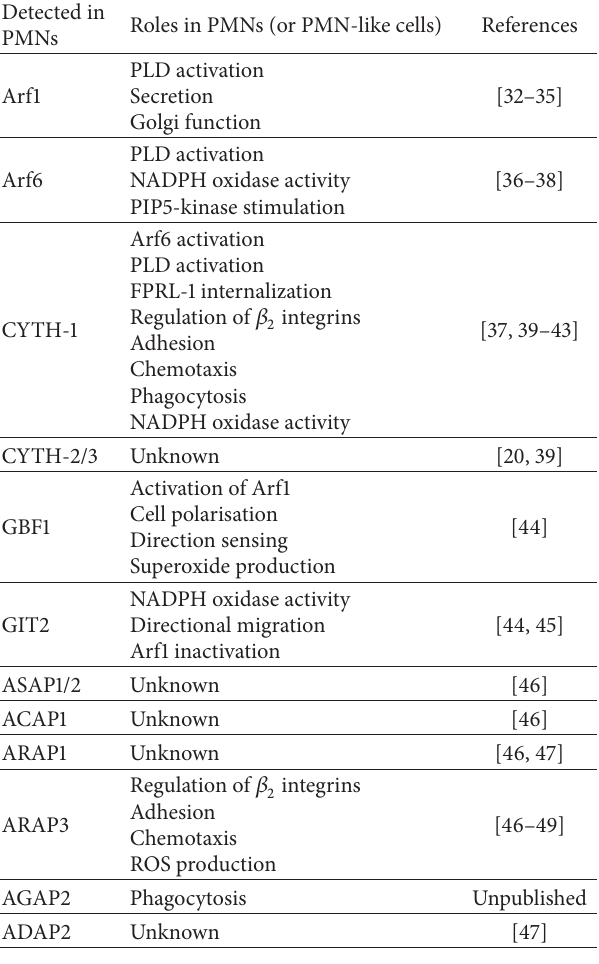
Table 1: Neutrophil functions modulated by Arfs and their regula-